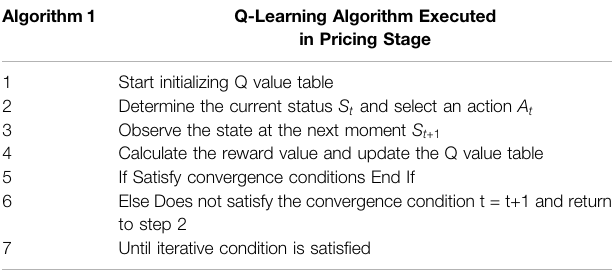
TABLE 1 | Flowchart for implementing the Q-learning mechanism. Algorithm 1 Q-Learning Algorithm Executed in Pricing Stage